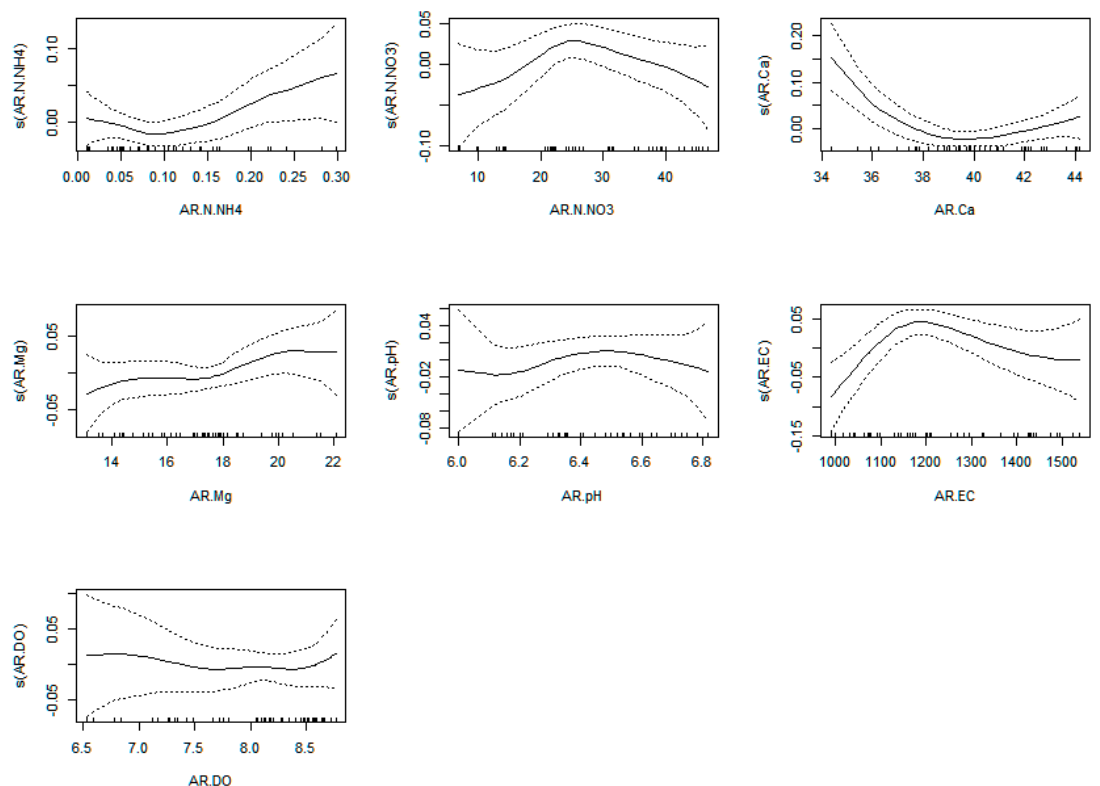
Figure A23. The GAM predictors influence over N-NO 2 for AR experimental variant.